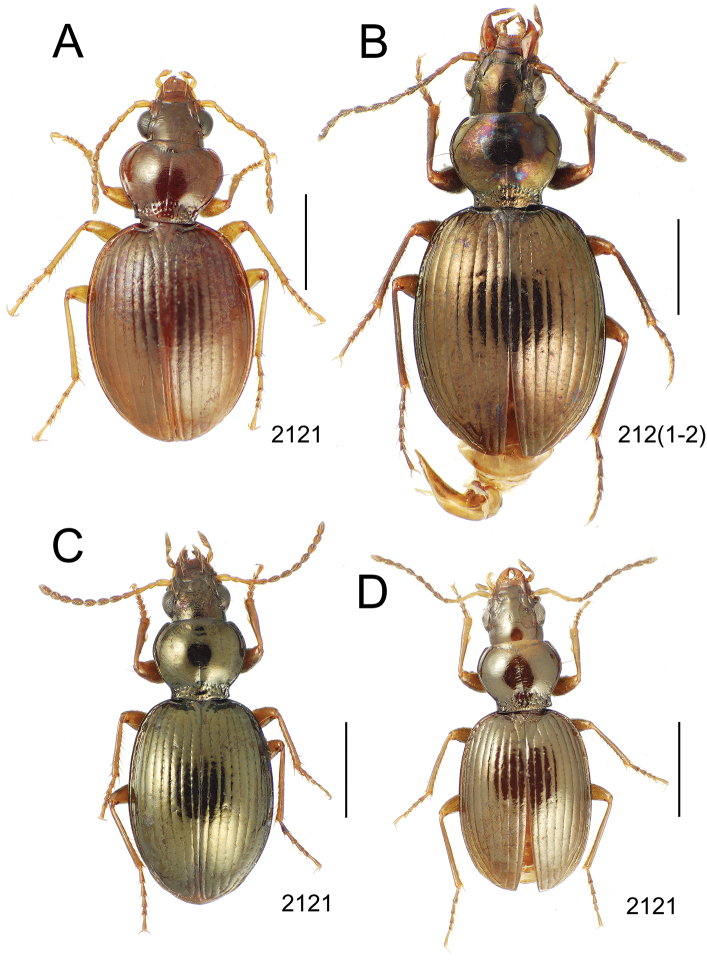
Mecyclothorax spp., dorsal view; scale bars 1.0 mm; setal formula (see Fig. 10) at lower right of each figure A
Mecyclothorax angulosus teneral female B
Mecyclothorax cupreoides paratype male (MHNB) C
Mecyclothorax laevilateralis
D
Mecyclothorax globulosus allotype female